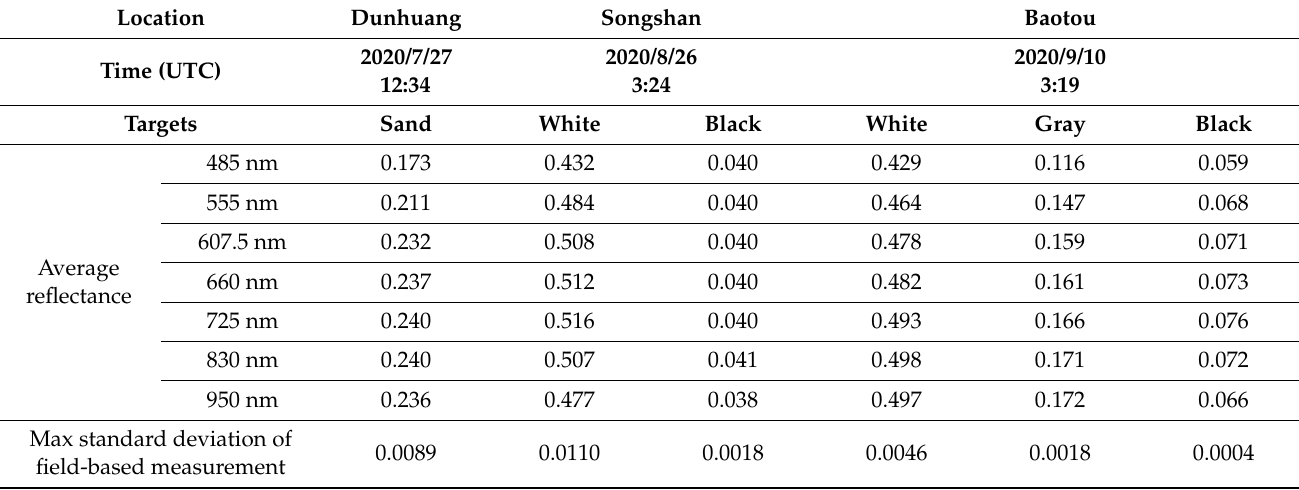
Table 5. Detailed information of field-based test